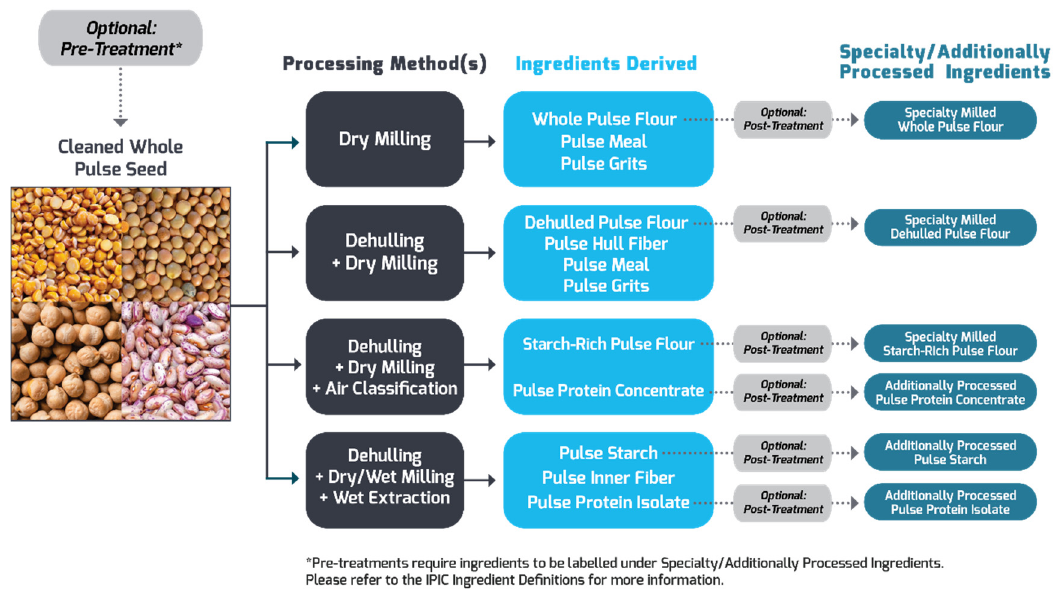
Figure 1. Outline of processing steps of pulses involved in the production of different pulse-derived ingredients (as defined by the International Pulse Ingredient Consortium [39]).